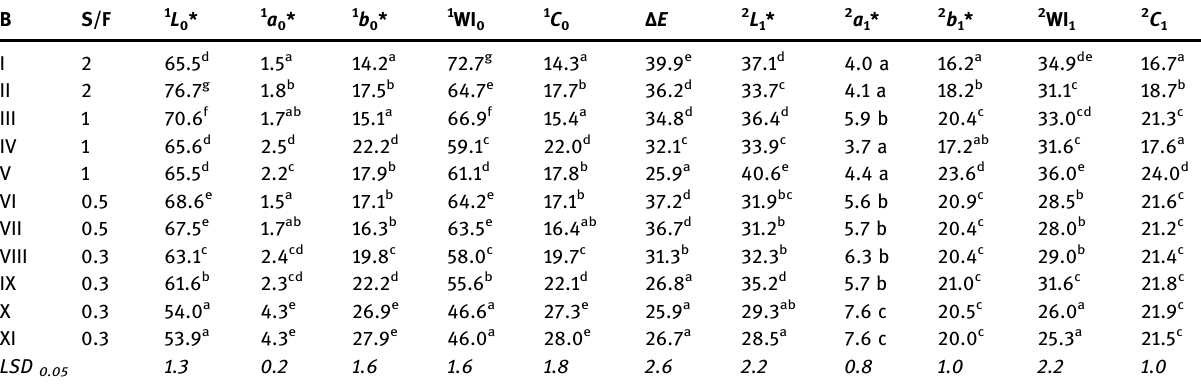
Table 4: Colour properties of samples*